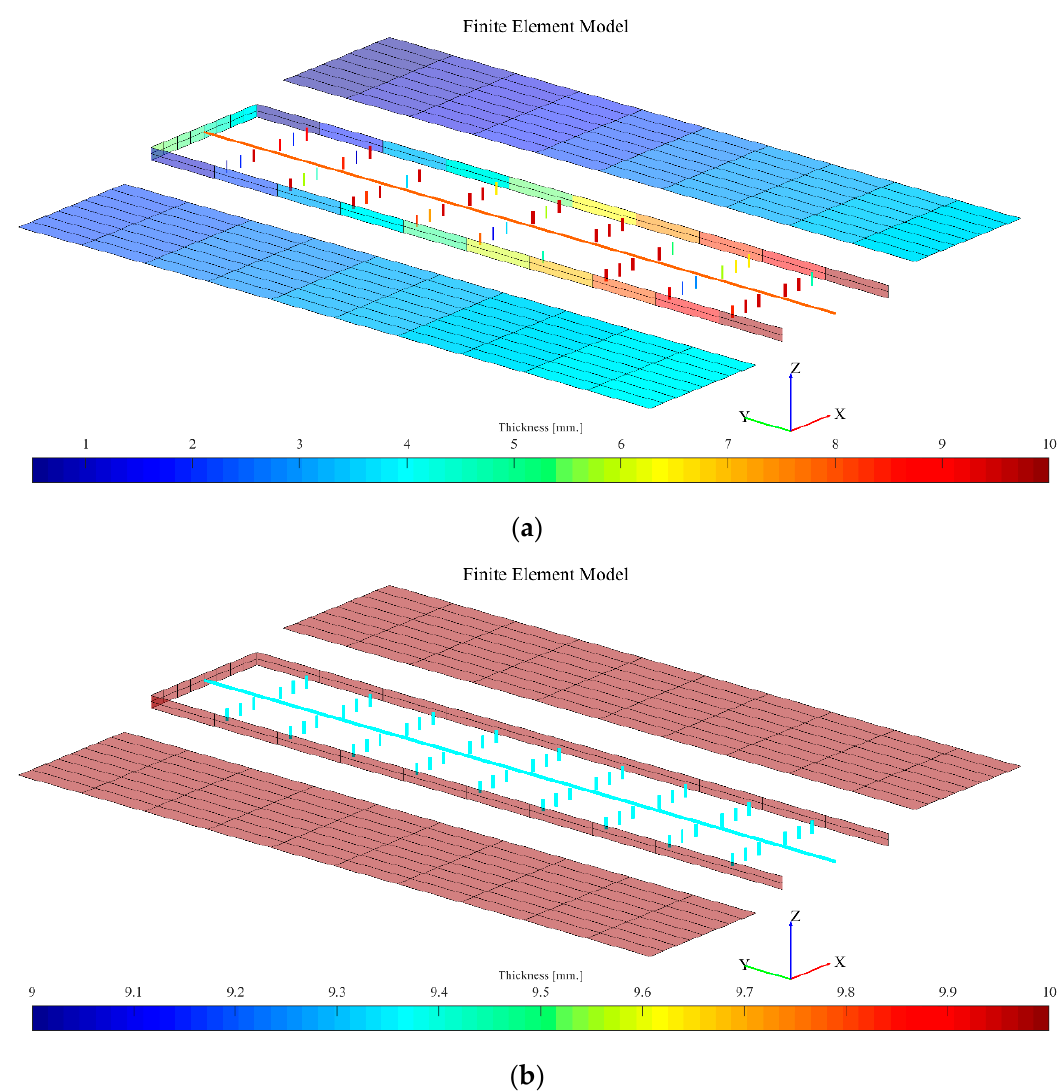
Figure 12. Thickness and skeletal rods diameter plot of the selected optimum solutions ( a ) 1 and ( b ) 10 Case II with color bar.